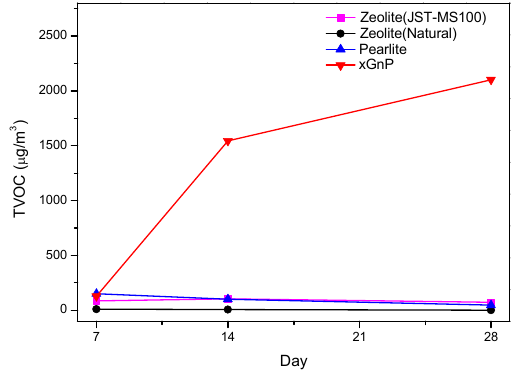
Figure 3. TVOC adsorption amount of xGnP for 28 days.